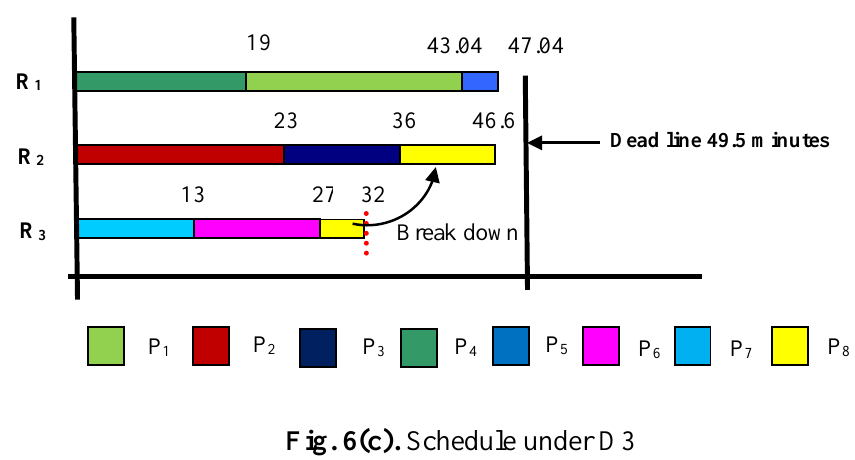
Fig. 6(c). Schedule under D3